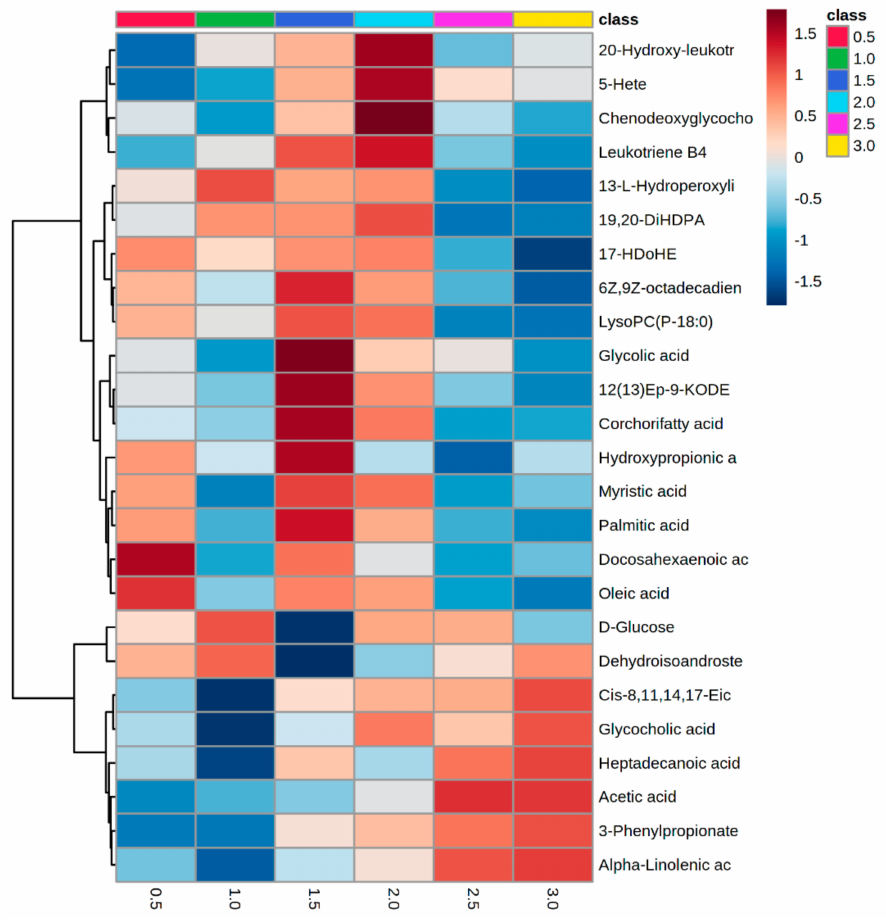
Figure 2. HCA of the major metabolite changes differentiating between HF heifers aged between 0.5 and 3.0 months of age in the combined ionization mode m/z .